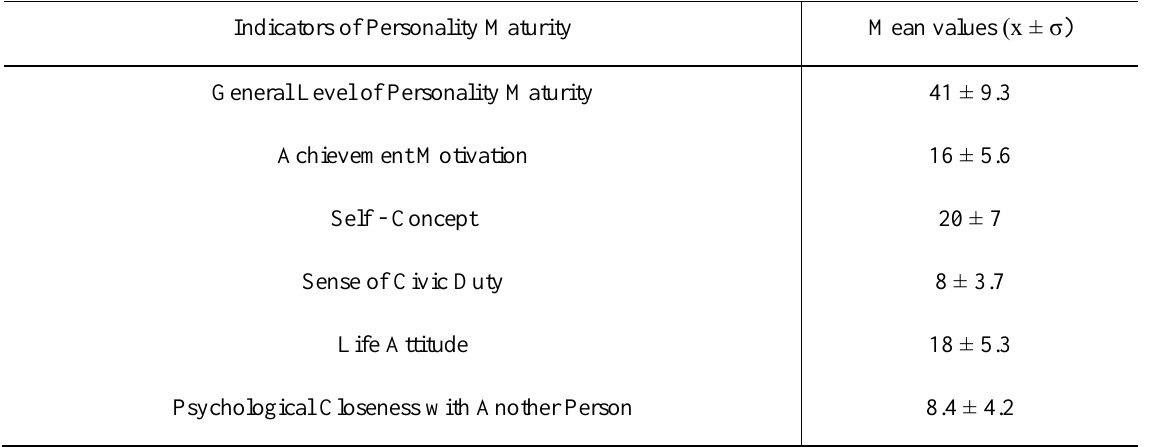
Table 2. Analysis of the Mean Values for Indicators of Personality